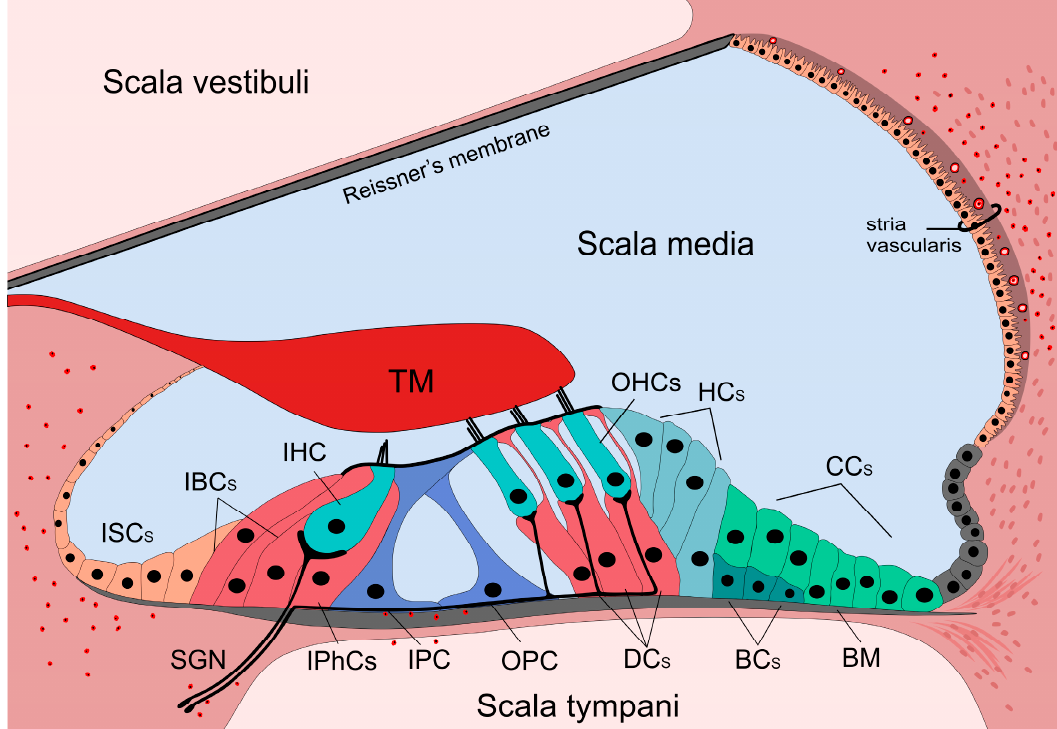
Figure 1. Anatomy of the organ of Corti and the presence of immune cells. The cochlea is divided into three chambers (scalae) by two membranes. The organ of Corti is located in the scala media. The three rows of outer hair cells (OHCs) and the one row of inner hair cells (IHCs) are surrounded by di ff erent types of supporting cells. The cells are surrounded by the perilymph, but the stereocilia of the hair cells are bathed in the endolymph. The reticular lamina is formed by the apical parts of the cells establishing a barrier between the endo- and perilymphatic fluid compartments. The basilar membrane (BM) separates the scala media and tympani. Supporting cells (IBCs, IPhCs, IPC, OPC, DCs, HCs, CCs, BCs) span through the cellular layer of the organ while hair cells (IHC and OHCs) are not in direct contact with the BM, but their stereocilia reaches the tectorial membrane (TM). Resident macrophages and leukocytes are always present in the cochlea, primarily in the spiral limbus, in the scala tympani side of the BM as well as in the lateral wall. Red formations with black dots in the middle show position of these immune cells. ISCs: Inner sulcus cells; IBCs: Inner boarder cells; IPhCs: Inner phalangeal cells; IPC: Inner pillar cell; OPC: Outer pillar cell; DCs: Deiters’ cells; HCs: Hensen’s cells; CCs: Claudius’ cells; BCs: Boettcher’s cells. IHC and OHCs: Inner and outer hair cells; SGNs: Spiral ganglion neurons; TM: Tectorial membrane.